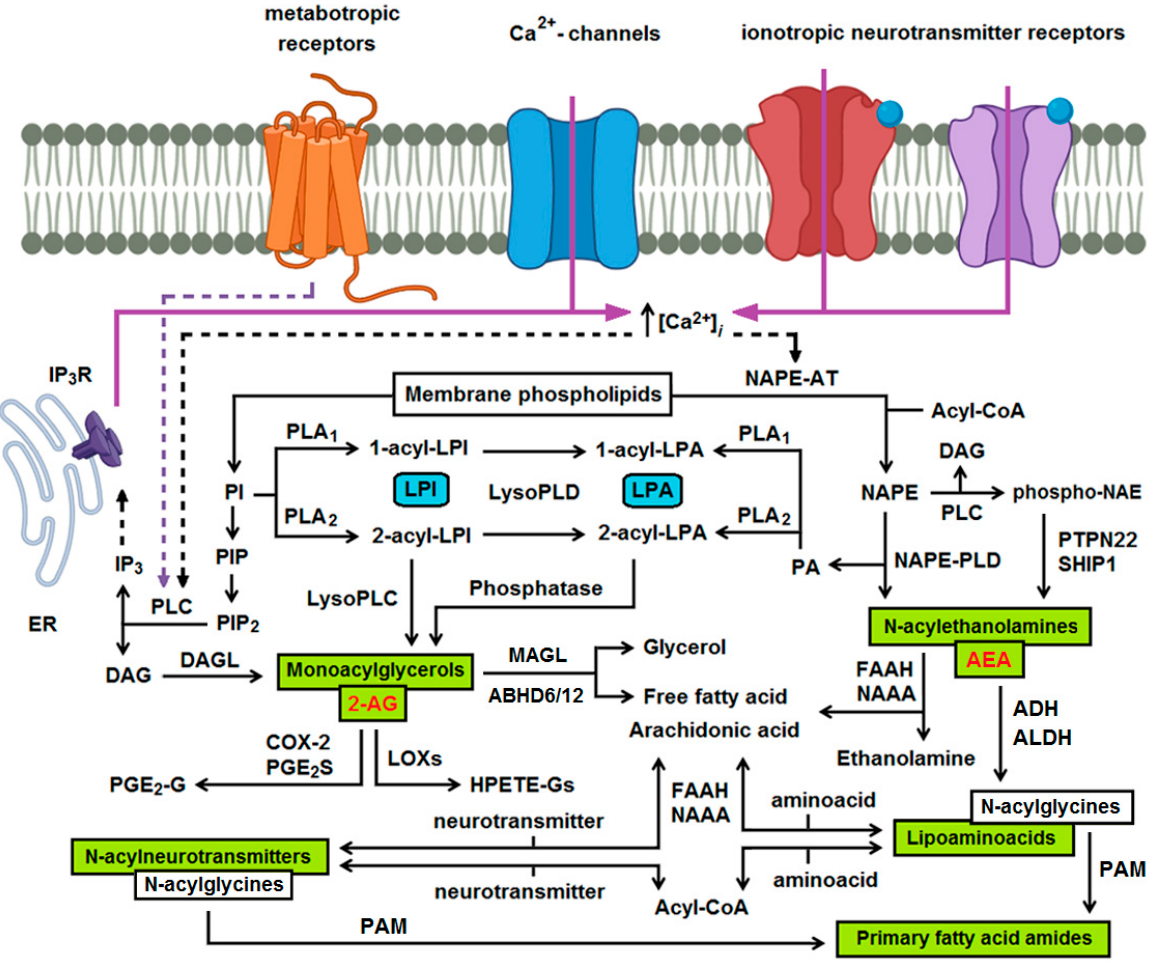
Figure 1. Main pathways of endocannabinoid (eCB) generation and degradation. Monoacylglycerols, such as 2—arachidonylglycerol (2-AG) and N-acylethanolamines such as arachidonoylethanolamide (AEA) are generated from membrane phospholipids and provide precursors used in the synthesis of lipoaminoacids and N-acylneurotransmitters. Production of eCBs is associated with the generation of lysophospholipids, like lysophosphatidylinositol (LPI) and lysophosphatidic acid (LPA). ABHD6/12, alpha/beta-hydrolase domain containing 6/12; ADH, alcohol dehydrogenase; 2-AG, 2-arachidonylglycerol; ALDH, aldehyde dehydrogenase; COX, cyclooxygenase; DAG, diacylglycerol; DAGL, diacylglycerol lipase; FAAH, fatty acid amide hydrolase; HPETE-Gs, glycerol esters of 12- or 15-hydroperoxyeicosatetraenoic acid; IP 3 R, inositol trisphosphate receptor; LOXs, lipoxygenases; MAGL, monoacylglycerol lipase; NAAA, NAE-hydrolyzing acid amidase; NAE, N-acylethanolamine, NAPE, N-acyl-phosphatidylethanolamine; NAPE-AT, NAPE forming N-acyltransferase; PA, phosphatidic acid; PAM, peptidyl-glycine alpha-amidating monooxygenase; PGE 2 -G, prostaglandin E 2 –glycerol ester; PGE 2 S, prostaglandin E 2 synthase; PI, phosphatidylinositol; PIP, phosphatidylinositol 3 - phosphate; PIP 2 , phosphatidylinositol 4,5-bisphosphate; PL, phospholipase; PTPN22, protein tyrosine phosphatase non-receptor type 22; SHIP1, SH-2 containing inositol 5 ′ polyphosphatase 1.